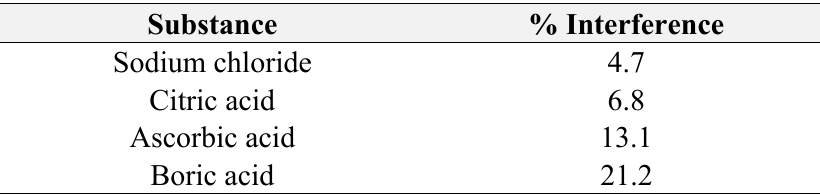
Table 2. The effect of possible interfering